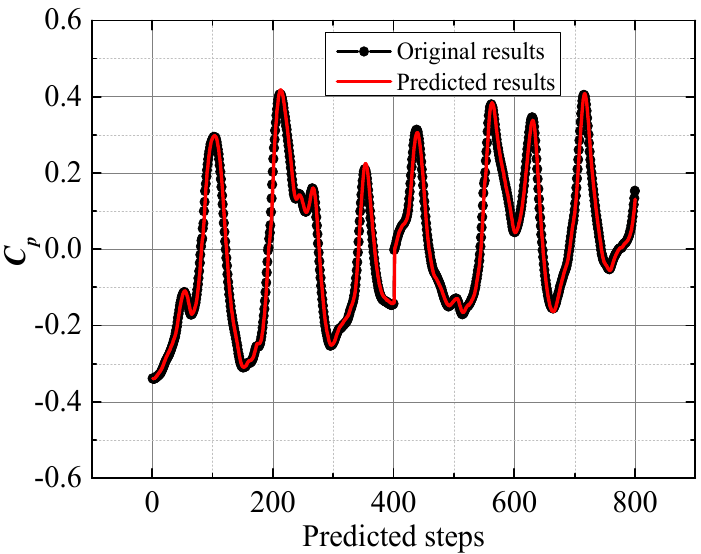
Figure 17. Predicting results of RBF-NNM when an irregular undesired signal existed.